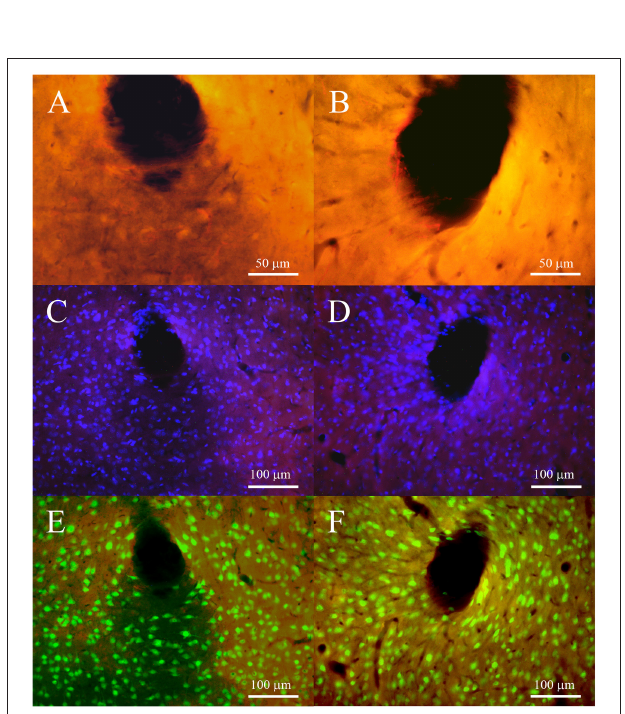
FIGURE 8 | (A) In vivo impedance spectra (magnitude) of non-encapsulated microspheres at 1 (red), 7 (green), 14 (blue), 21(cyan), and 28 (black) days AFTER the implant. (B) In vivo impedance spectra (magnitude) of pHEMA encapsulated PEDOT-PSS-CNT coated microspheres at 1 (red), 7 (green), 14 (blue), 21(cyan), and 28 (black) days after the implant.